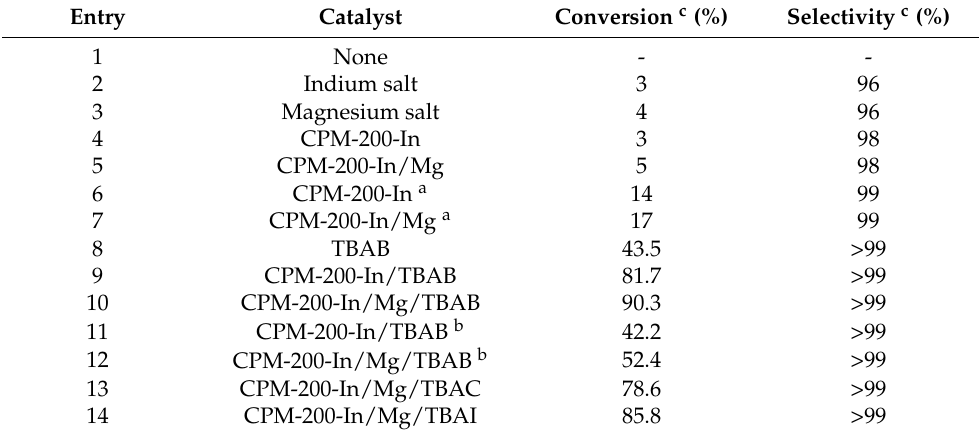
Table 3. Catalytic activity comparison of catalysts for the cycloaddition reaction of ECH and CO 2 .